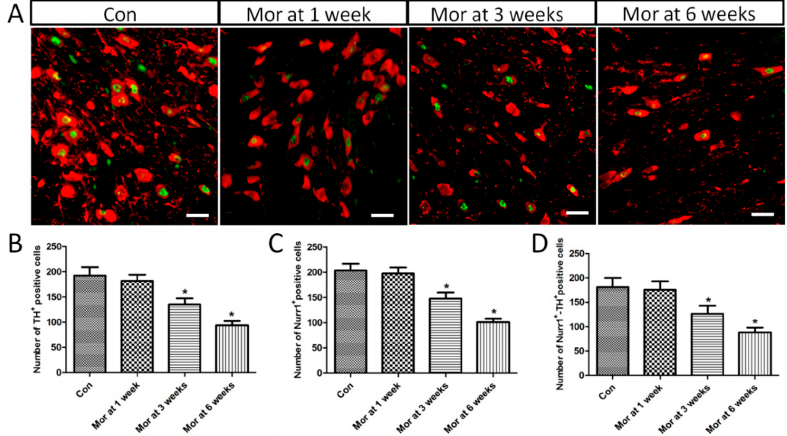
Figure 4. ( A ) Representative images showing the co-localization of Nurr1 and TH positive cells expression in the VTA. Bars = 25 μ m. ( B – D ) Quantitative analysis of TH + , Nurr1 + and Nurr1 + -TH + positive cells. The data are shown as mean ± SEM, * P < 0.05 vs. control group ( n = 8).